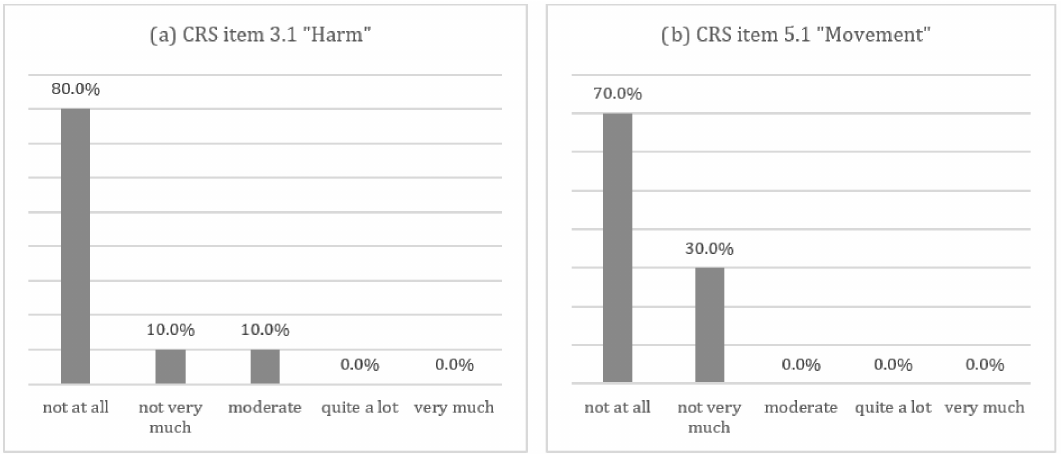
Figure 3. Chart of the Comfort Rating Scale’s (CRS) most representative items: ( a ) patients’ answer to the Comfort Rating Scale Item 3.1 “Harm”: the device caused me some harm (e.g., headache, pain, itching, irritation, etc.); ( b ) patients’ answer to the Comfort Rating Scale Item 5.1 “Movement”: the devices badly affects the way I move or slows down or obstructs my